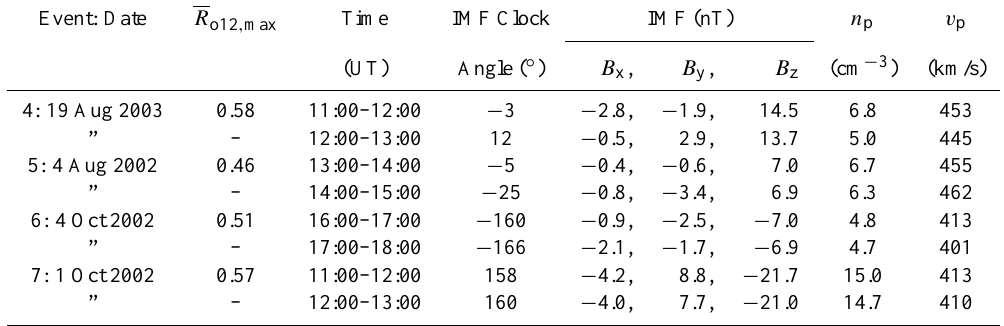
Table 3. Current region overlap fraction and average solar wind and IMF parameters for the Ørsted comparison intervals of Figs. 6, 7, 8, and 9 as indicated in the Event: date column and in order from top to bottom. All ACE data are lagged using simple advection. The clock angle is evaluated from the average vector projection in the Y - Z GSM